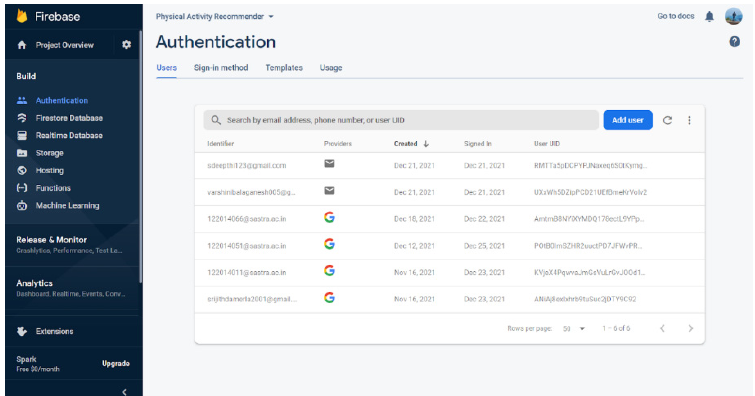
Figure 11. Firebase console for Google authentication.